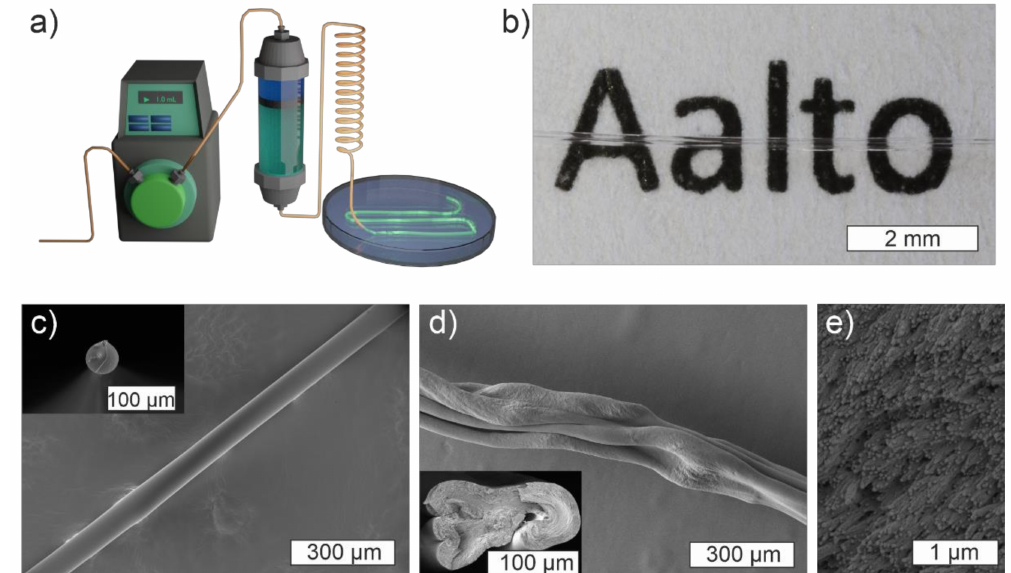
Figure 6. Fiber spinning and morphology. ( a ) Schematics drawing of wet-spinning setup components: a pump, sample container, capillary tube, and a coagulation bath. ( b ) Transparent MC fibers prepared from 3% MC hydrogel. ( c ) SEM image of a fiber wet-spun from 2% MC hydrogel showing smooth and homogeneous morphology. The inset shows the cross-sectional shape of the respective fiber. ( d ) SEM micrograph of fiber spun from a MC-CNC 1.0–3.0% nanocomposite hydrogel, showing buckled and twisted shape. The inset shows an uneven cross-sectional shape. ( e ) Fractured cross-section of a fiber wet-spun from a 4.0% MC hydrogel shows an array of aligned internal nanoscale structures. ( d ) Adapted with permission from [49], copyright 2019 Elsevier; and ( a – c ) and ( e ) adapted with permission from [36], copyright 2021 John Wiley and